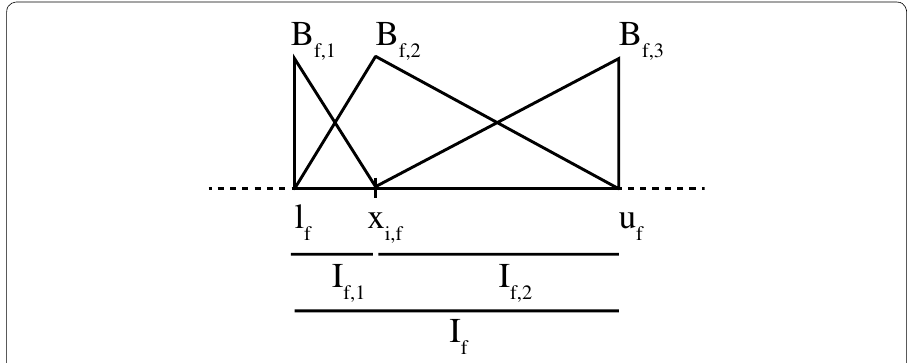
Fig. 1 An example of the fuzzy partition P I f ( x i , f ) in the interval I f defined by l f , x i , f and u